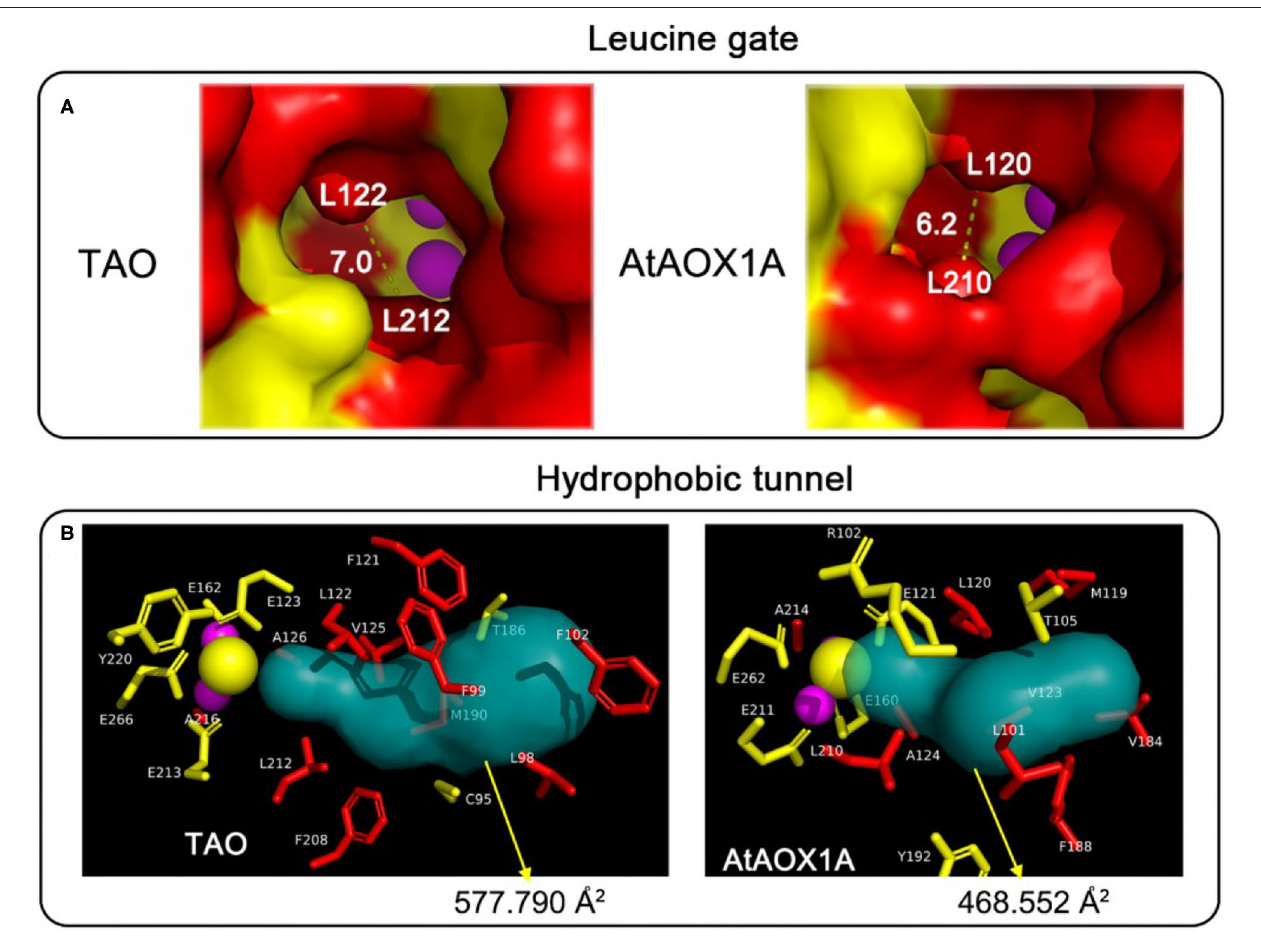
FIGURE 8 | Comparison of the protein tunnel between TAO and AtAOX1A. (A) Comparison of the leucine gate between TAO and AtAOX1A. Schematic representation of the entrance to the ubiquinone/ubiquinol cavity for TAO and AtAOX1A, respectively. The red-colored surface represented the hydrophobic cavity, whereas the yellow-colored surface represented the hydrophilic residues. (B) Comparison of the quinol tunnel and the atoms around the quinol tunnel between TAO and AtAOX1A. The hydrophobic tunnels were analyzed using Caver 3.0 software. Atoms around the hydrophobic tunnel within 6 Å were analyzed, and the side chain of these residues was shown in a different color. Red, hydrophobic residues; yellow, hydrophilic residues; purple sphere, di-iron center; yellow sphere, OH − .